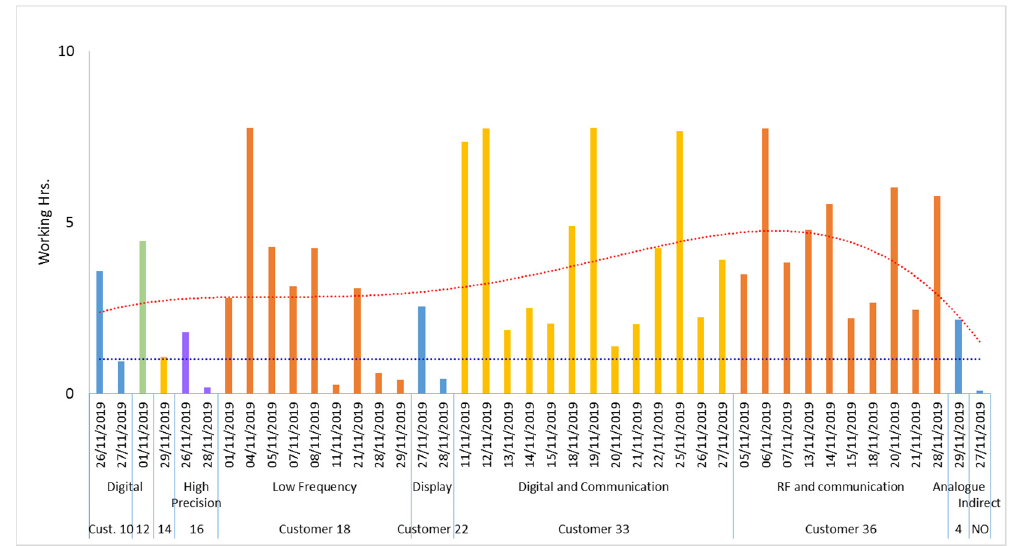
Figure 15. Test operator (TO) 16 (Technician)—November 2019.